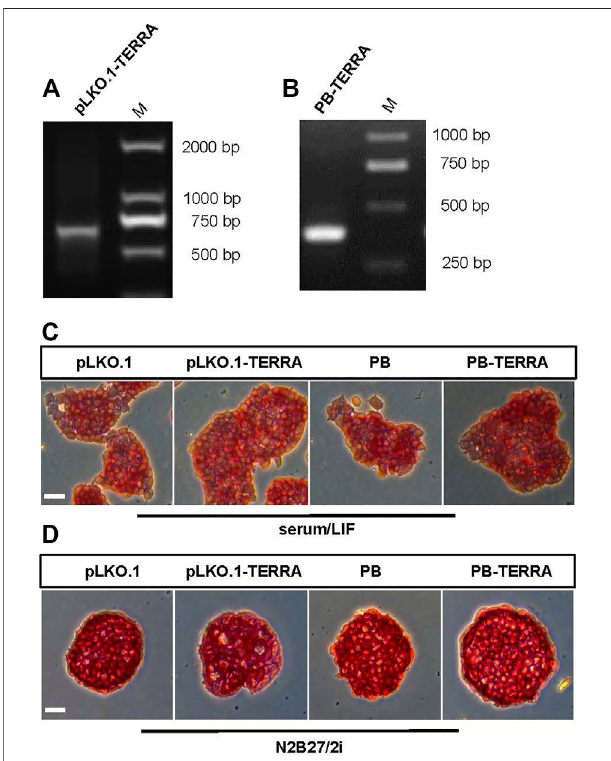
FIGURE 1 | Exogenous TERRA expression in mouse embryonic stem cells (mESCs). (A,B) PCR identi fi cation of recombinant TERRA expression with and without polyadenylation in 46C mESCs, using primers speci fi c for PB-TERRA and pLKO.1-TERRA plasmids. (A) : the fragment at 708-bp contains the 300-bp recombinant TERRA and the 408 bp plasmid fragment. (B) :thefragmentat466-bpcontains the300-bprecombinantTERRAandthe 166 bp plasmid fragment. M, molecular marker. (C,D) Alkaline phosphatase (AP) staining images of mESCs overexpressing TERRA with and without polyadenylation cultured in serum with LIF or N2B27 with 2i (CHIR and PD03) media. Scale bar, 100 μ